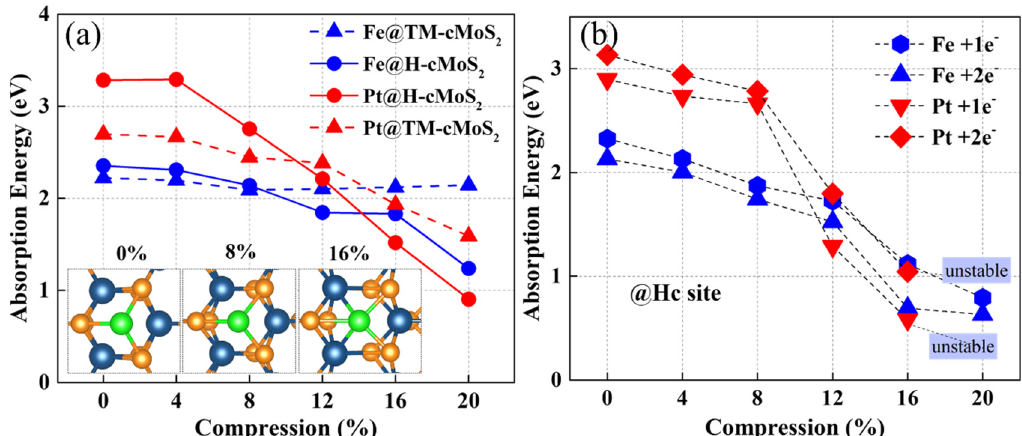
Figure 2. ( a ) The adsorption energy of metal atoms on neutral cMoS 2 as a function of compressions. The insets represent the top view of M@cMoS 2 at different compressions. ( b ) The adsorption energy of metal atoms on the H site of charged cMoS 2 as a function of compressions.